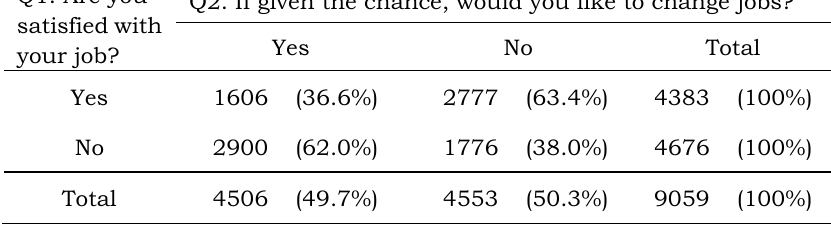
Table 1. Job satisfaction and turnover candidates (1992–2000 JPC Survey) Q1. Are you Q2. If given the chance, would you like to change satisfied with your job?